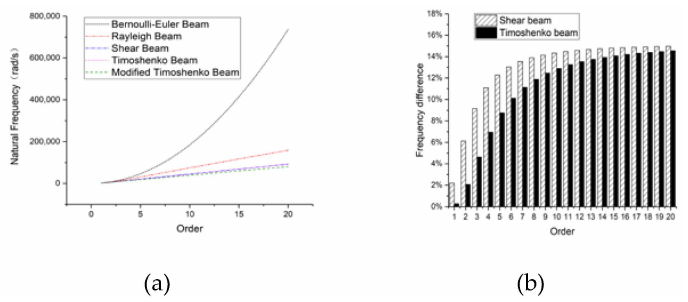
Figure 6. Natural frequencies of the 2-m-long beam: ( a ) overall frequency curve and ( b ) frequency di ff erence compared with a modified Timoshenko